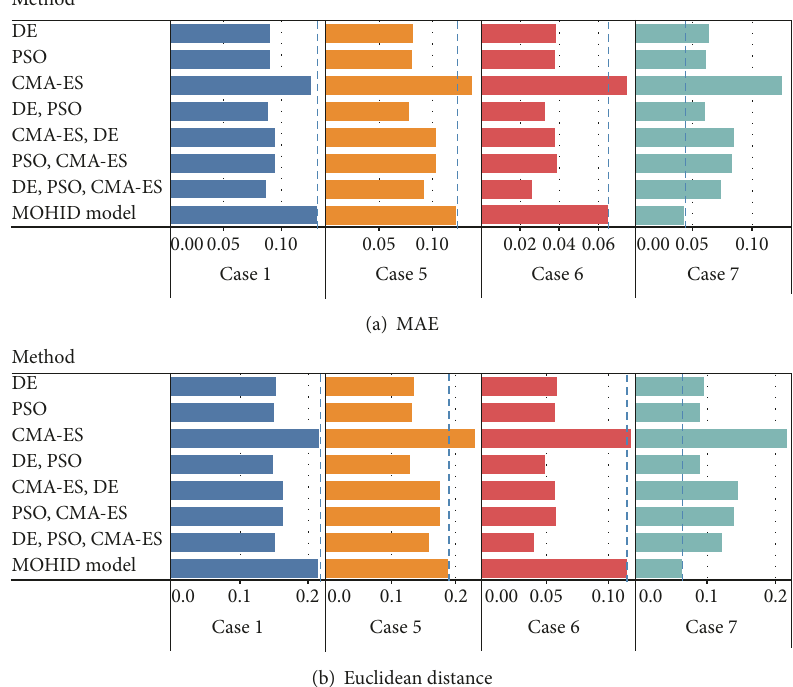
Figure 10: Bar graph of MAE and Euclidean distance for all the tested predictive models on four test cases. The lower the values, the better.